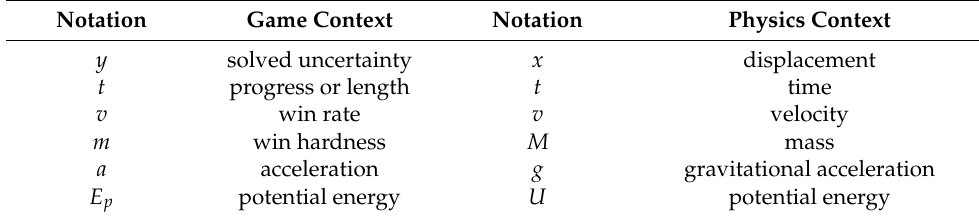
Table 1. Analogical link between game and physics